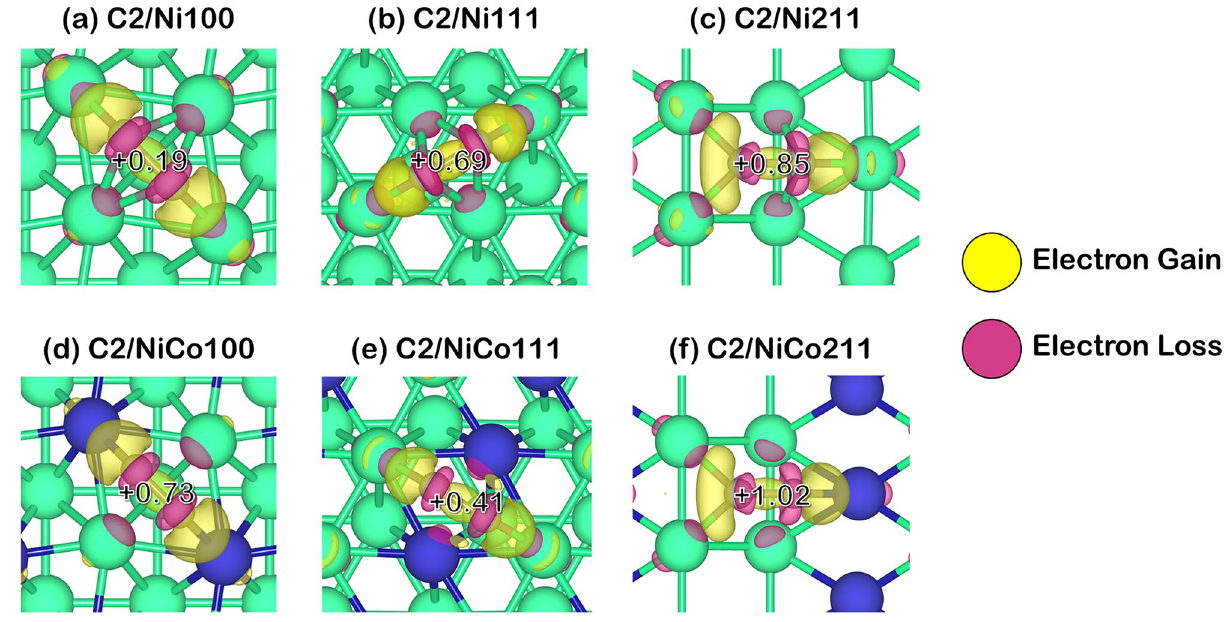
Figure 7. The charge density difference corresponding with Bader charge changes of C2 coke species adsorption on Ni and NiCo surfaces with an isovalue of ± 0.015 |e|/Å 3 .